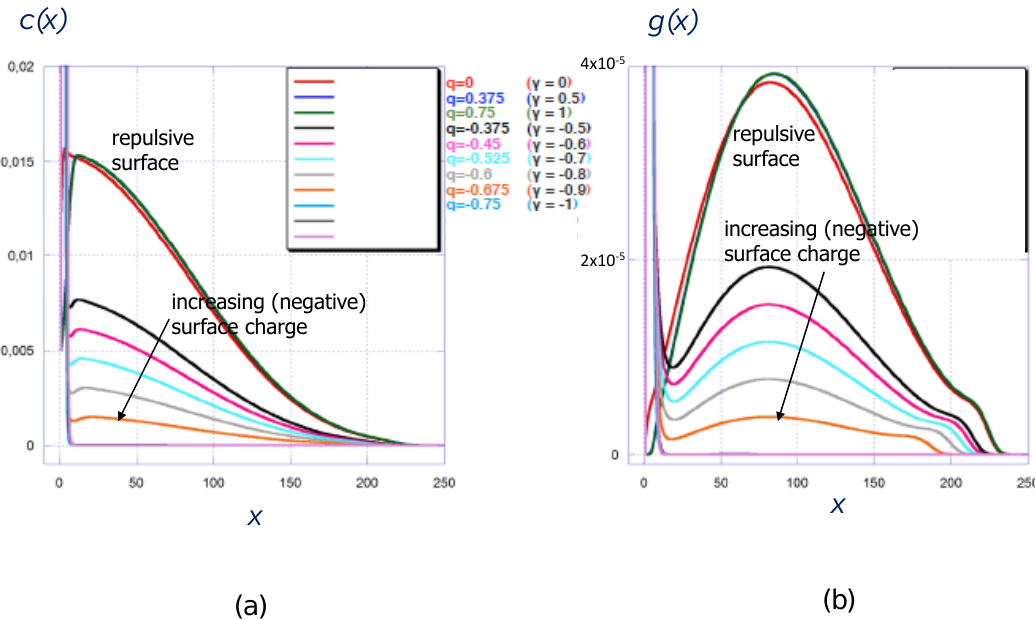
Figure 2. Strong polyelectrolyte brush: distribution of polymer density ( a ) and free chain ends ( b ) at various values of reduced surface charge density γ = σ / α N . Other parameters: N = 300, α = 0.5, a 2 / s = 0.001, salt concentration c s a 3 = 10 − 5